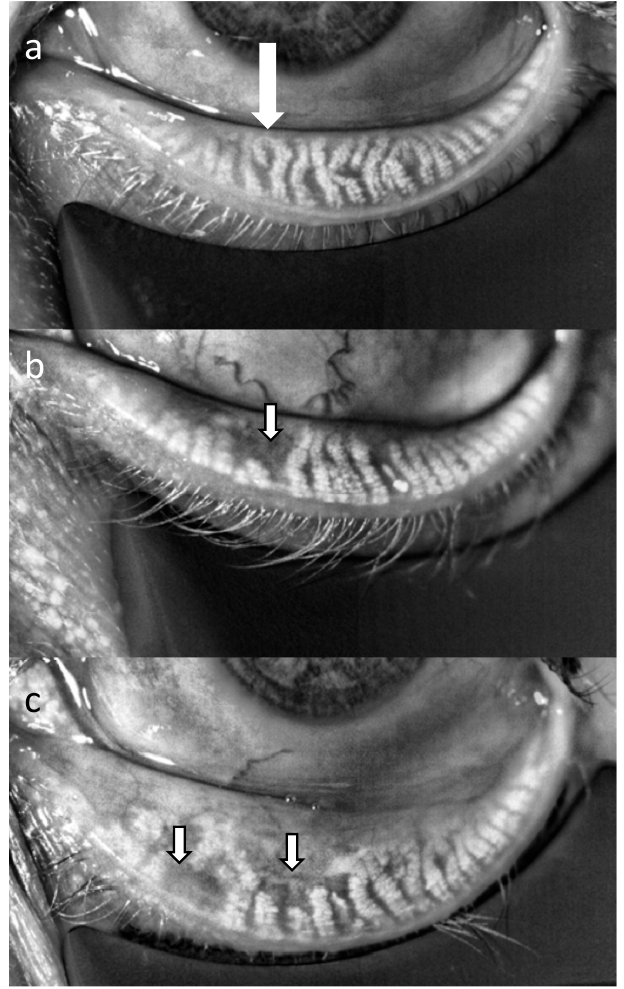
Figure 4. Infrared images of the Meibomian glands of the lower eyelid in a healthy subject ( a ), a patient with mild Meibomian gland dysfunction (MGD) ( b ) and a patient with moderate MGD ( c ). Areas of gland dropouts can be clearly seen (arrows). The images were taken with the LipiView interferometer (TearScience, Morrisville, NC, USA).